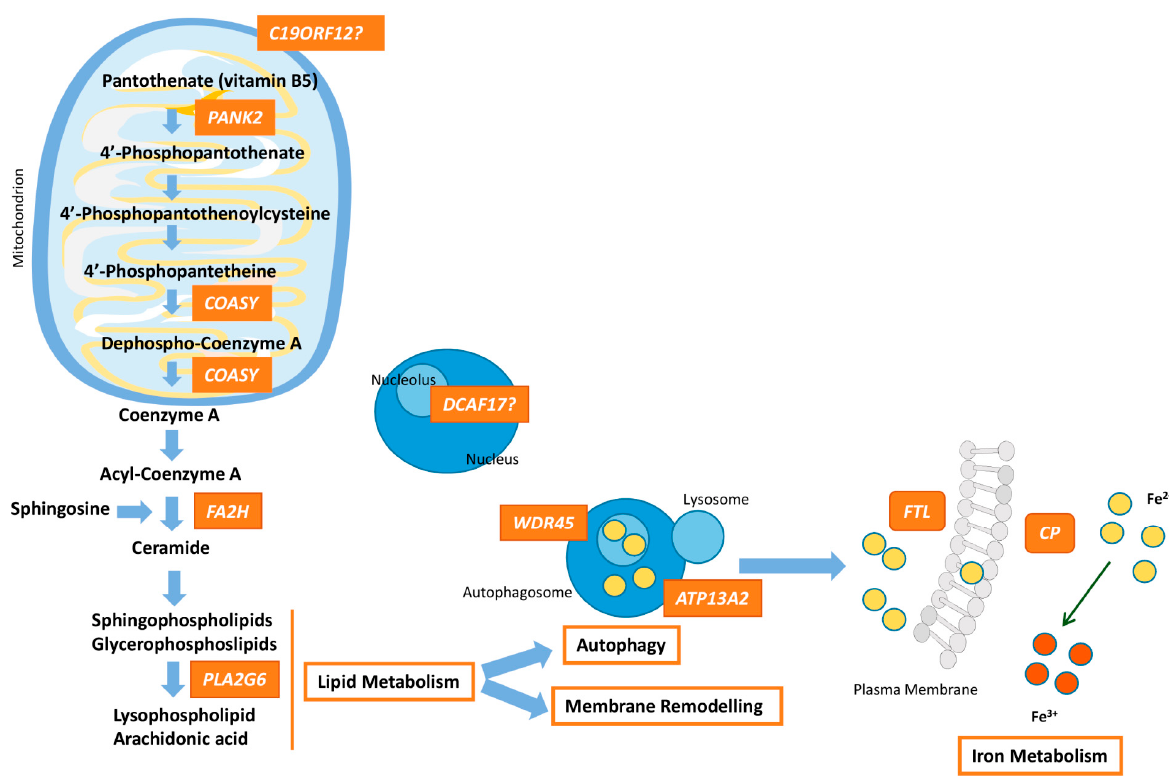
Figure 1. Pathway connecting lipid synthesis, lysosomes dysfunction and iron accumulation in NBIA syndromes. PANK2, COASY, FA2H and PLA2G6 defects lead to harmed phospholipid membrane synthesis and impaired myelination or myelin maintenance. Dysfunctional membranes may lead to lysosomal and mitochondrial damage causing ROS production and iron uptake upregulation. WDR45 and ATP13A2 are involved in autophagosome formation / degradation. The decrease of WDR45 protein expression causes the accumulation of aberrant autophagic structures. Lysosomal dysfunction due to ATP13A2 defect, which may originate from impaired phospholipid recycling, could ultimately cause degradation of substrates and damage of autophagosome clearance. Moreover, perturbation of lysosomes is important for iron homeostasis and may promote deposits of iron. Dysfunction of FTL prevents the recruitment of iron excess and malfunctioning of CP causes impairment of iron export from the cell, responsible for iron overload. The higher free iron-dependent oxidative damage requires that the cell increases the degradation of oxidized molecules, which can a ff ect the cellular recycling systems, such as lysosomes, and finally, lead to cellular death. The role of DCAF17 remains unclear, although its dysfunction leads to a neurodegenerative disorders, and hence, in some way, DCAF17 may be related to mitochondrial